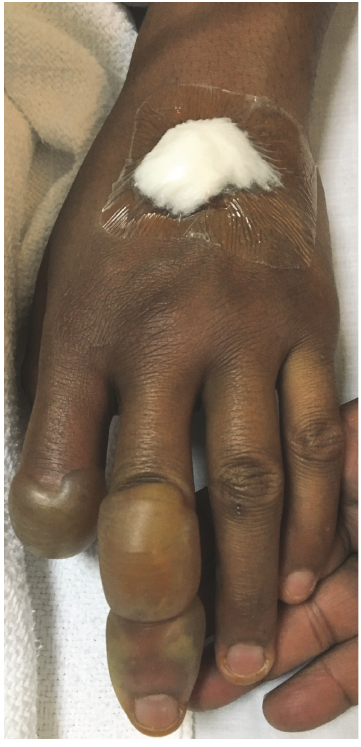
Figure 1: Tense blisters filled with serous fluid over dorsal hand.